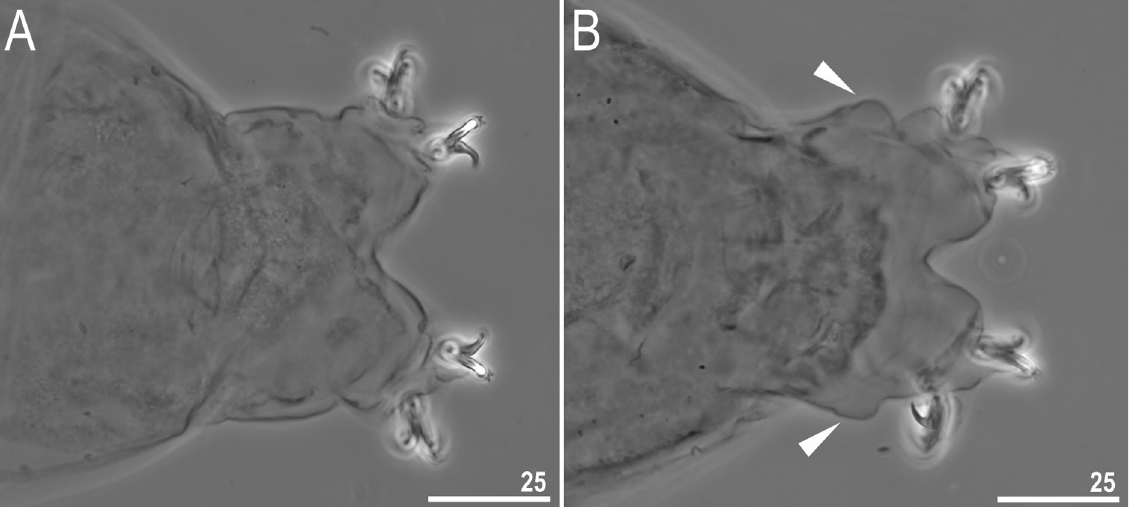
Fig. 9. Macrobiotus engbergi sp. nov. Secondary sexual dimorphism. A . Female without gibbosities on the hind legs. B . Male with gibbosities on the hind legs. Arrowheads indicate gibbosities. Scale bars in μm.